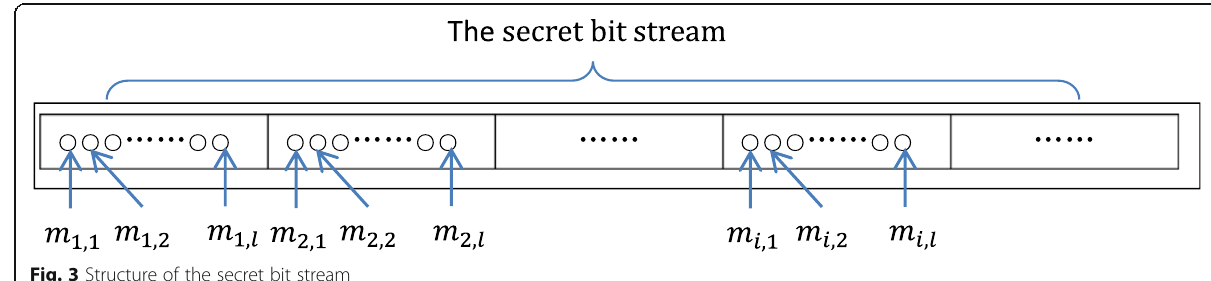
Fig. 3 Structure of the secret bit stream